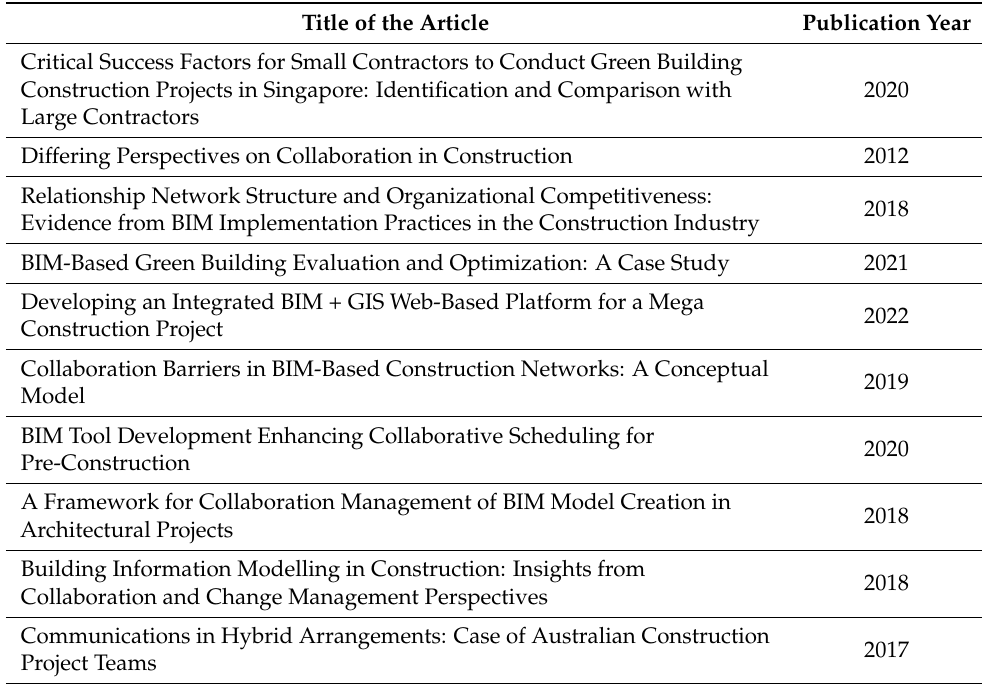
Table A2. Reviewed studies in Section 3.2.2 (sorted by order of